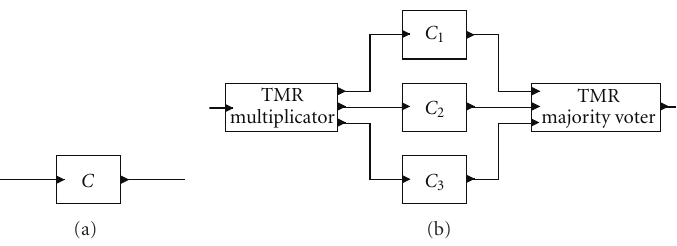
Figure 11: Triple modular redundancy adaptation pattern applied at KPN level. KPN task C in (a) is replicated by three as shown in (b).